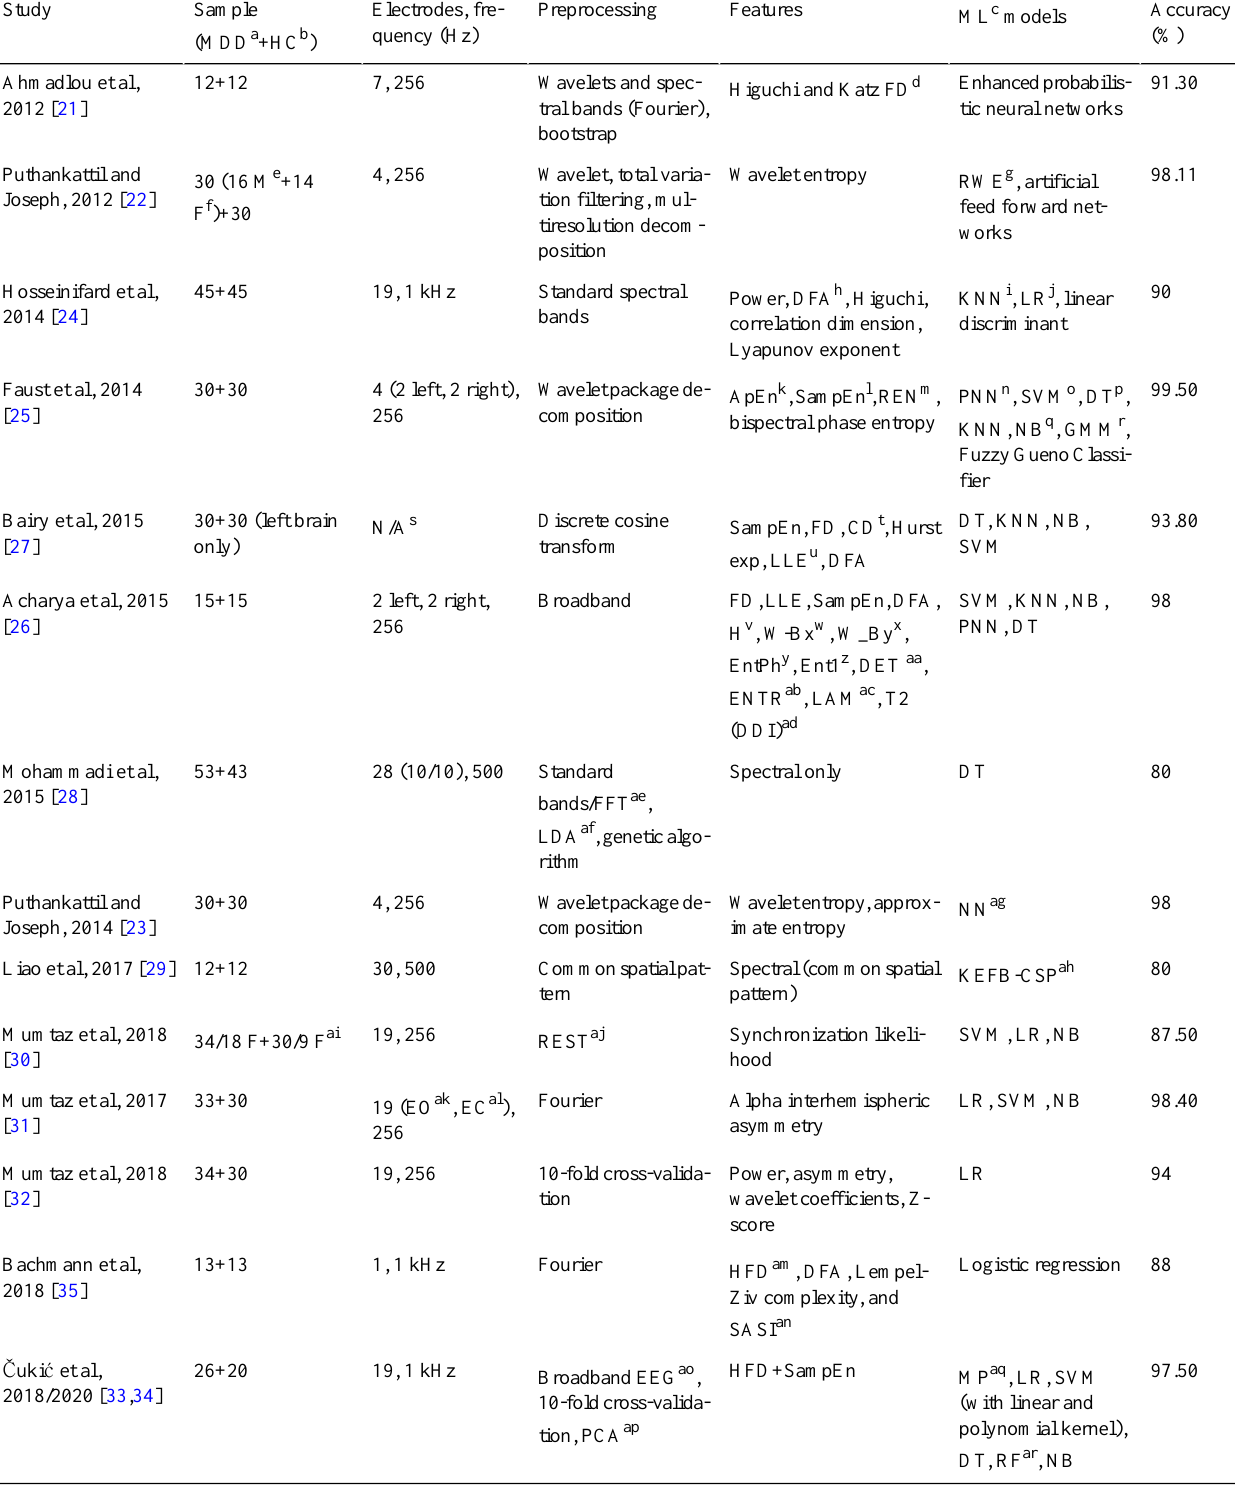
Table 1. A comparison of the previously mentioned studies comparing several characteristics, including their accuracy on the classification